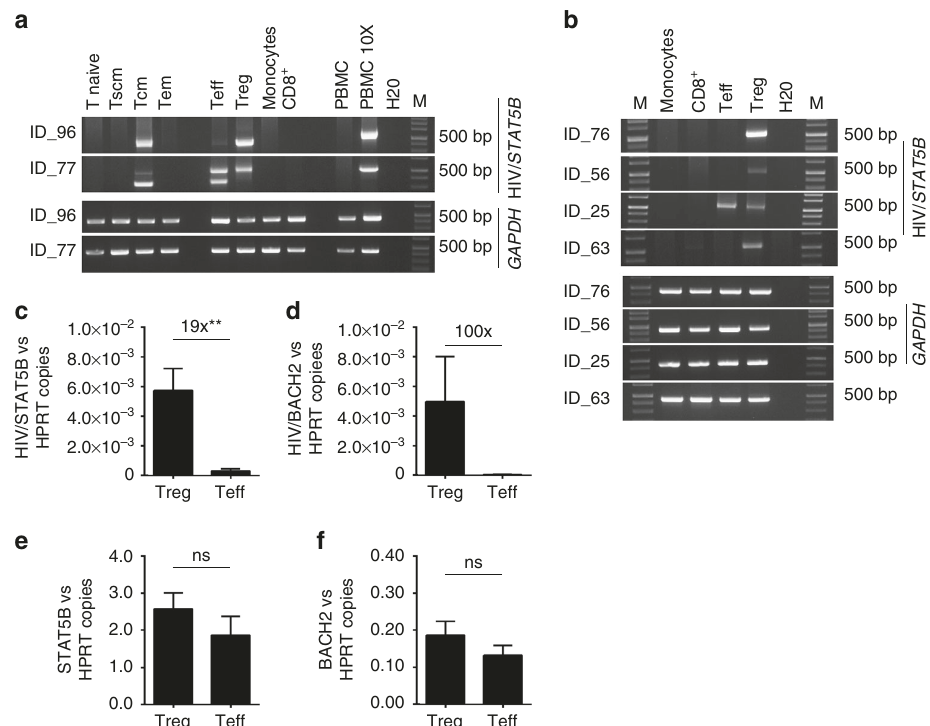
Fig. 3 Tracking and quanti fi cation of HIV/ STAT5B and HIV/ BACH2 chimeric transcripts in different hematopoietic cell subsets obtained from HIV patients under cART. a Top panel , agarose gel electrophoresis of the RT-PCR products (using the primers indicated in Fig. 1c) obtained from the cDNA of the indicated cell subsets puri fi ed by FACS sorting from two HIV-1 patients (ID-96, ID-77). For each cell subsets RT-PCR for GAPDH was also performed as positive control of ampli fi cation ( bottom panels ). In both patients, a speci fi c band of 500bp was obtained from the cDNA extracted from the puri fi ed Treg and Tcm cell subsets. In ID_77 two different bands appeared in the agarose gel due to splice variants of the STAT5B gene. In PBMC the band is detectable only when 10-fold more cDNA was loaded in the RT-PCR. The band was not detected in all the other cell types, including Tscm, T effector memory (Tem), and others. b Top panel , agarose gel electrophoresis of the RT-PCR products obtained from the cDNA of the indicated cell subsets puri fi ed by magnetic cell isolation in four HIV-1 patients (ID-76, ID-56, ID-25, ID-63). RT-PCR for GAPDH was also performed as positive control of ampli fi cation ( bottom panel ). M: molecular size marker. c , d Histograms show the average of the relative levels of the copies of the HIV/ STAT5B ( c ) and of the HIV/ BACH2 chimeric transcript ( d ) vs. HPRT copies measured by dd-PCR in Treg and Teff cells obtained from PBMC of six and three HIV-infected patients, respectively. e , f Histograms indicate the relative levels of the copies of STAT5B ( e ) and BACH2 ( f ) vs. HPRT copies measured by dd-PCR in Treg and Teff cells obtained from PBMC of six and three HIV-infected patients, respectively. Signi fi cance was determined by Mann – Whitney tests (** p < 0.01), SEM is indicated by the error